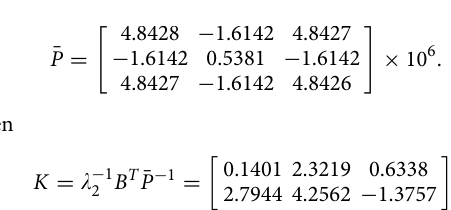
Figure 5. Curves of E